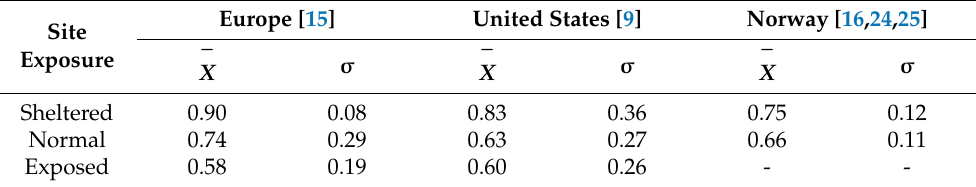
Table 2. Shape factors ( µ 1 ) for flat roofs in sheltered, normal, and exposed